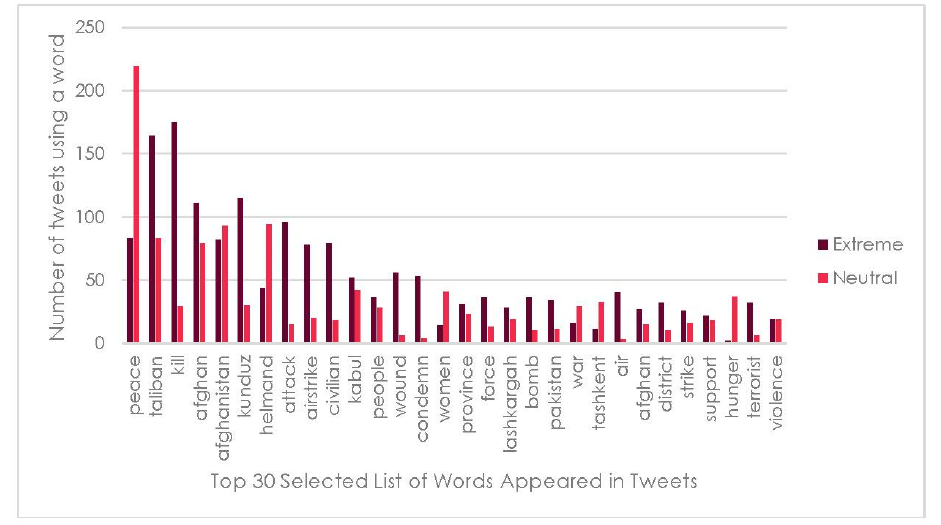
Figure 4. Words distribution .